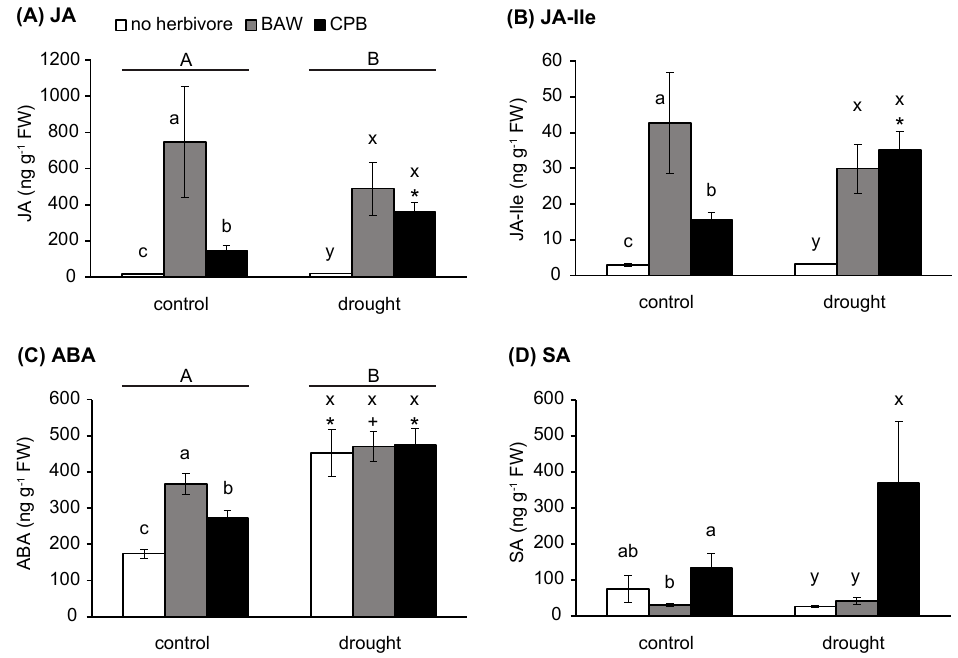
Figure 2. Effects of water availability and insect herbivory treatments on hormone concentrations in Solanum dulcamara leaves. ( A ) Jasmonic acid (JA), ( B ) JA ‐ isoleucine (JA ‐ Ile), ( C ) abscisic acid (ABA), and ( D ) salicylic acid (SA). Error bars are standard errors, n = nine per treatment combination. Bars indicate values of plants without herbivores (control, white bars), Spodoptera exigua (BAW, grey bars) and Leptinotarsa decemlineata (CPB, black bars). Different capital letters (A or B) indicate significant main effects (univariate, p < 0.05) of watering treatments. Different small letters (a, b, c in control